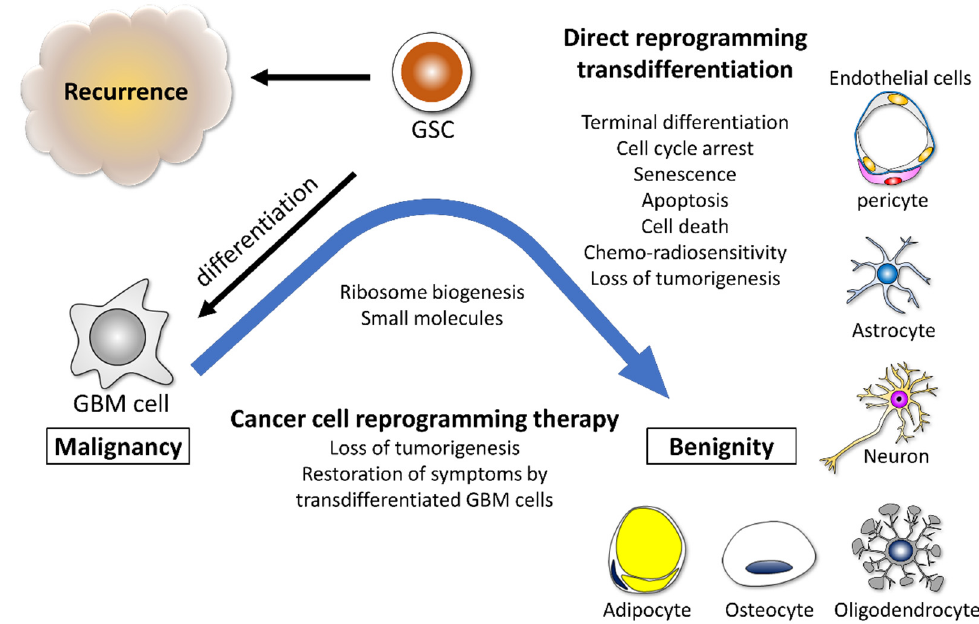
Figure 7. Cancer cell reprogramming therapy might convert malignancy to benignity. In reprogramming possesses, malignant phenotypes convert to benign phenotypes. By inducing terminal differentiation, a hypo-proliferation state, chemo-radiosensitivity, and tumorigenicity loss, GBM cells are eliminated or they exist as non-proliferating cells in the brain. Ideally, if terminally differentiated GBM cells possess normal neuronal functions and are integrated into a normal brain, tumor deletion and regenerative medicine to improve neurological deficits could coexist.